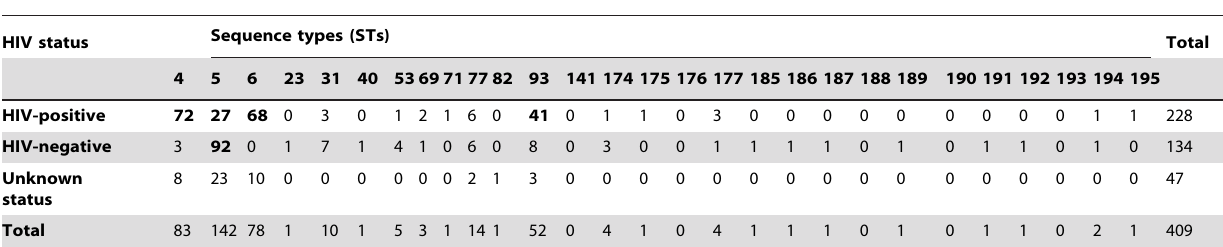
Table 3. Distribution of sequence types (STs) of C . neoformans var. grubii isolates according to HIV status of the patients.